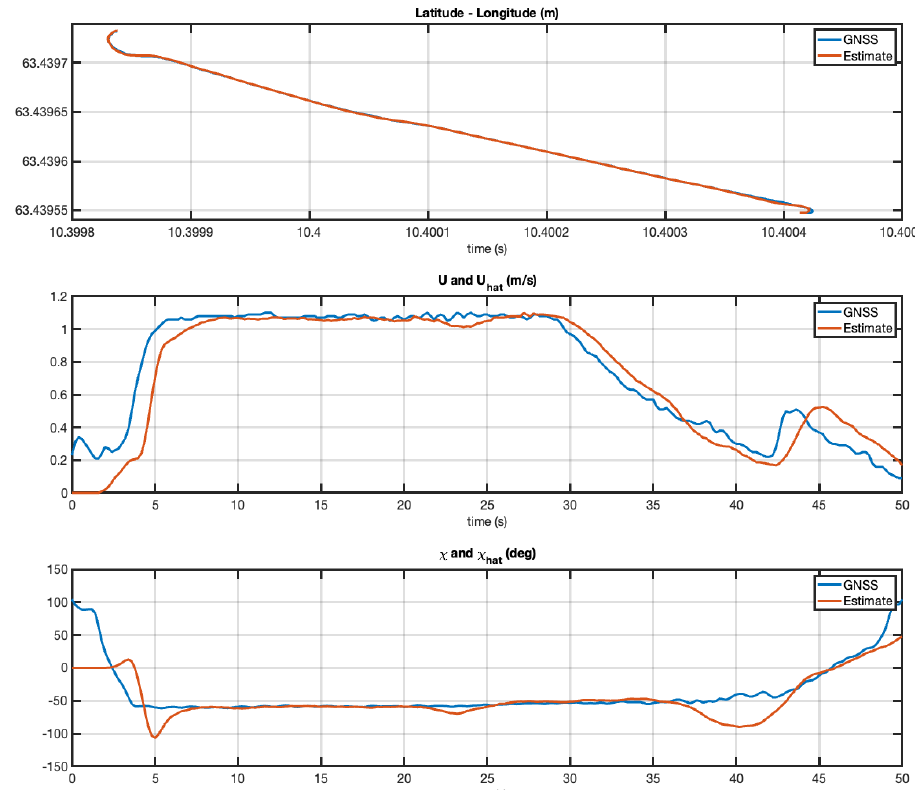
Figure 11. Experiment with the Otter USV in the harbor. Estimated SOG and COG versus time using latitude and longitude measurements at 5 Hz. The results are good when the vehicle moves at approximately 1.0 m/s and less accurate at very low